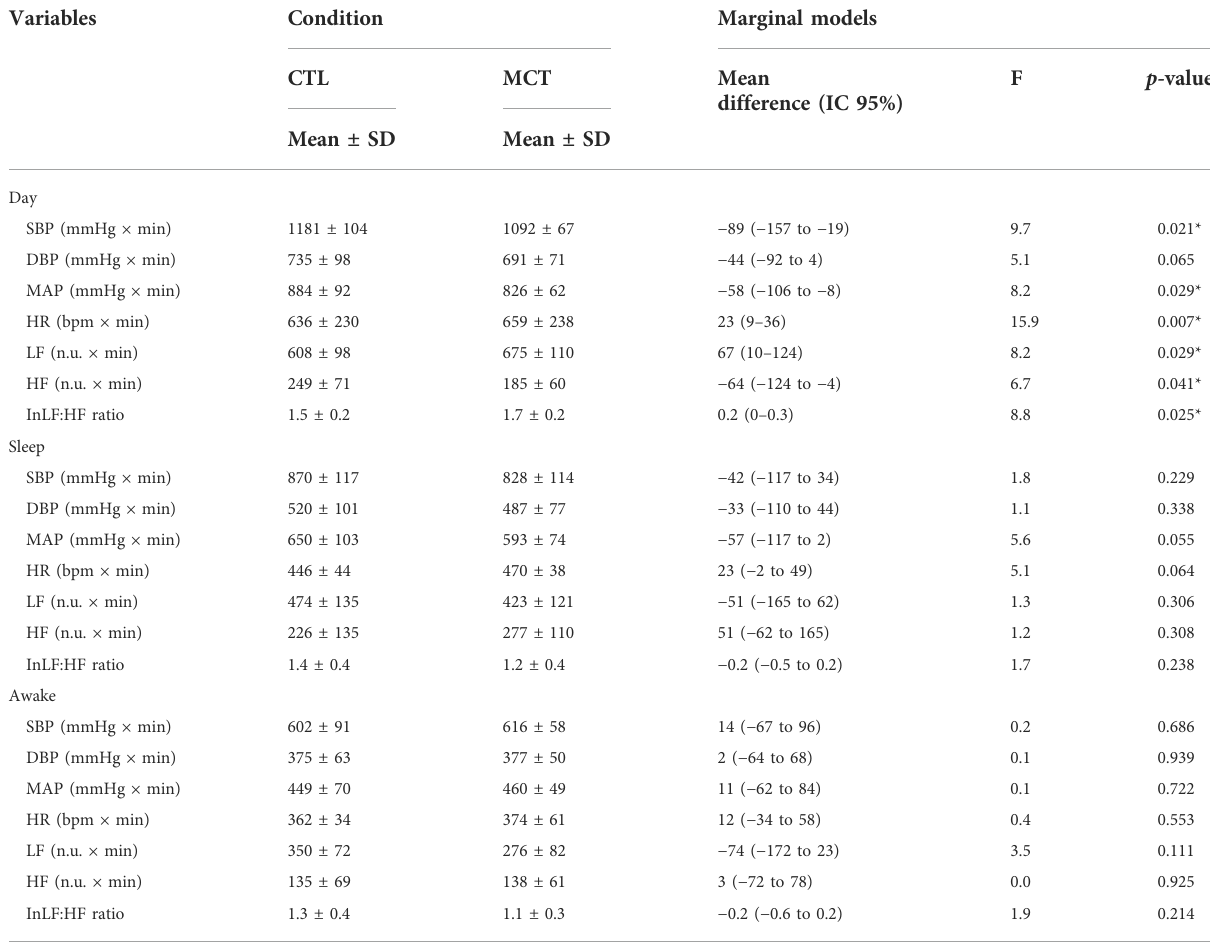
TABLE2Mean±SDAUCscalculated for hemodynamic andcardiac autonomiccontrolmarkersduring daytime(12:00 – 22:00 h),sleeping (22:00 – 06: 00 h), and waking hours (06:00 – 12:00 h) in the CTL and MCT conditions ( n = 7).